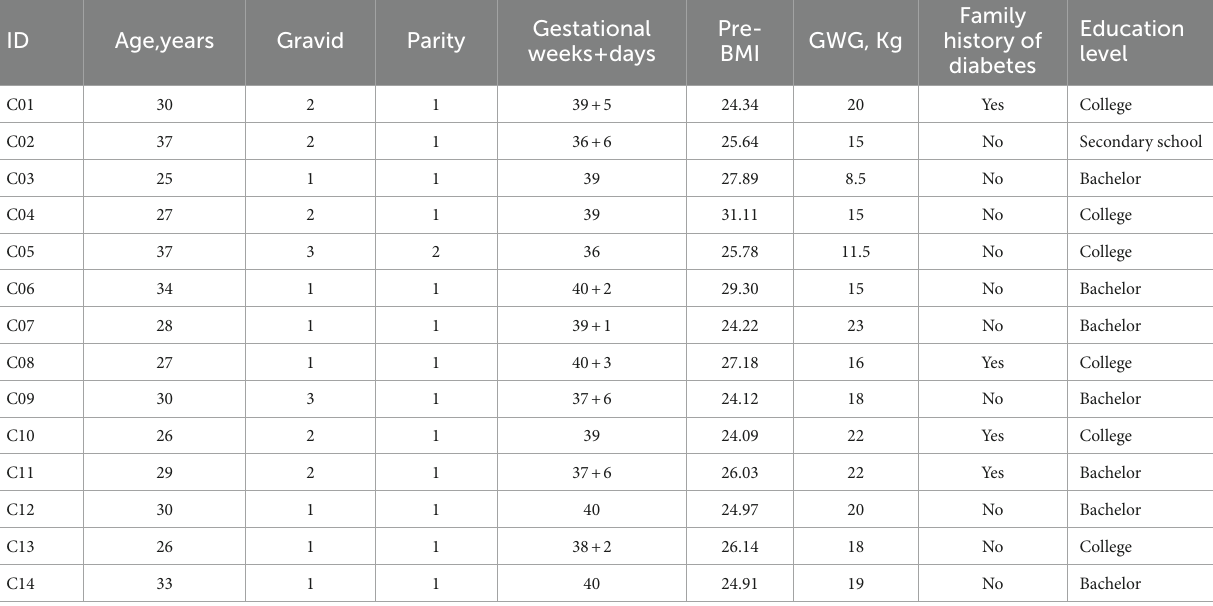
TABLE 1 Demographic information of the